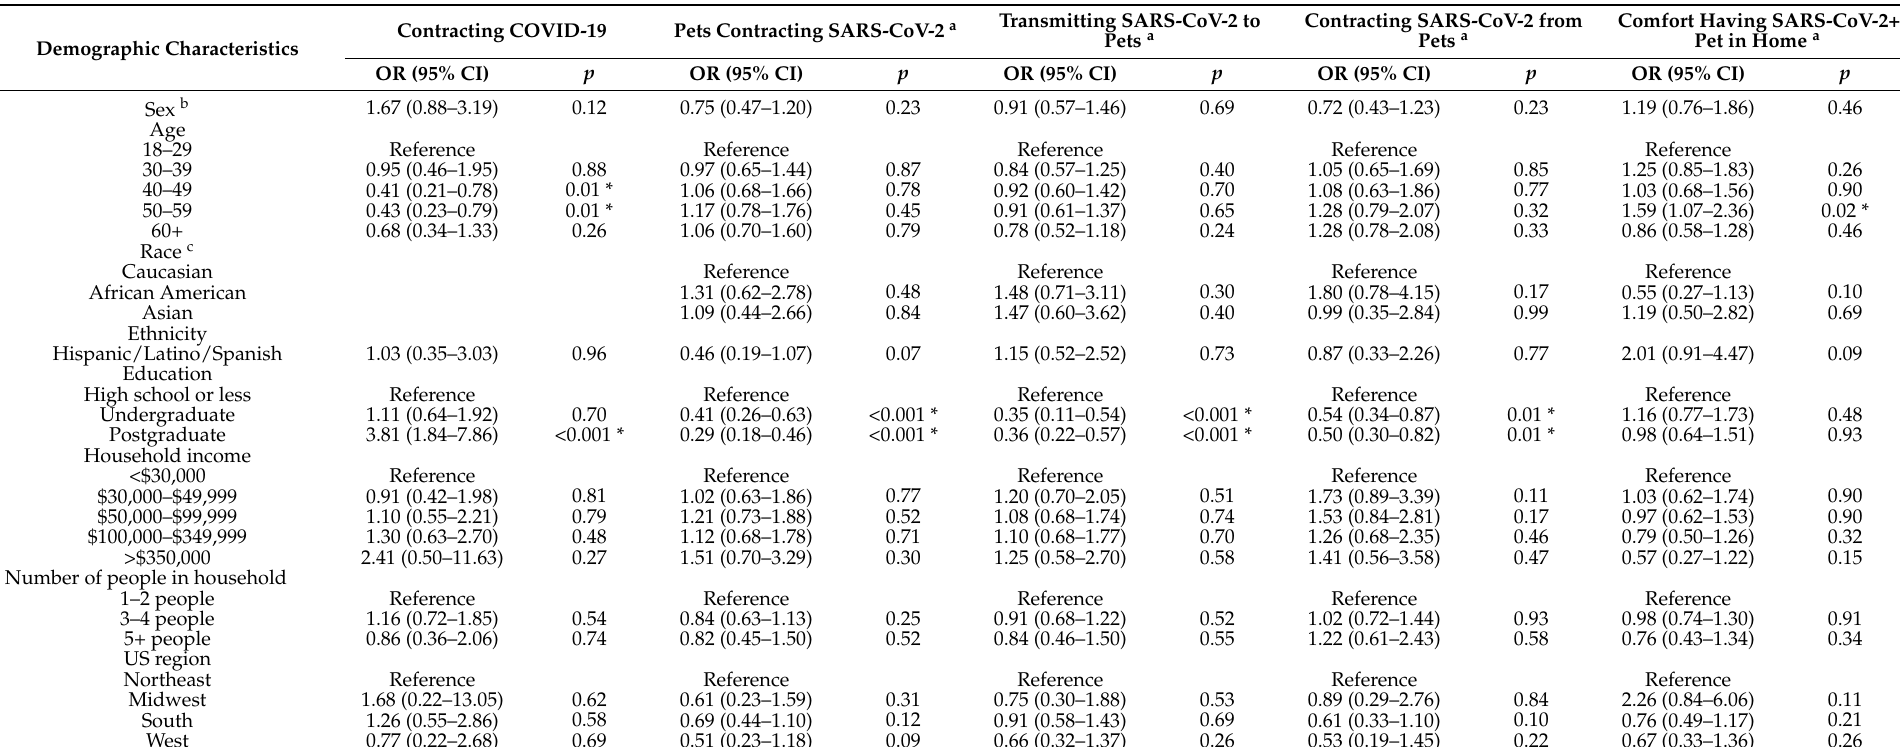
Table 4. Logistic regression models describing the associations between demographic characteristics and perceptions of zoonotic transmission of